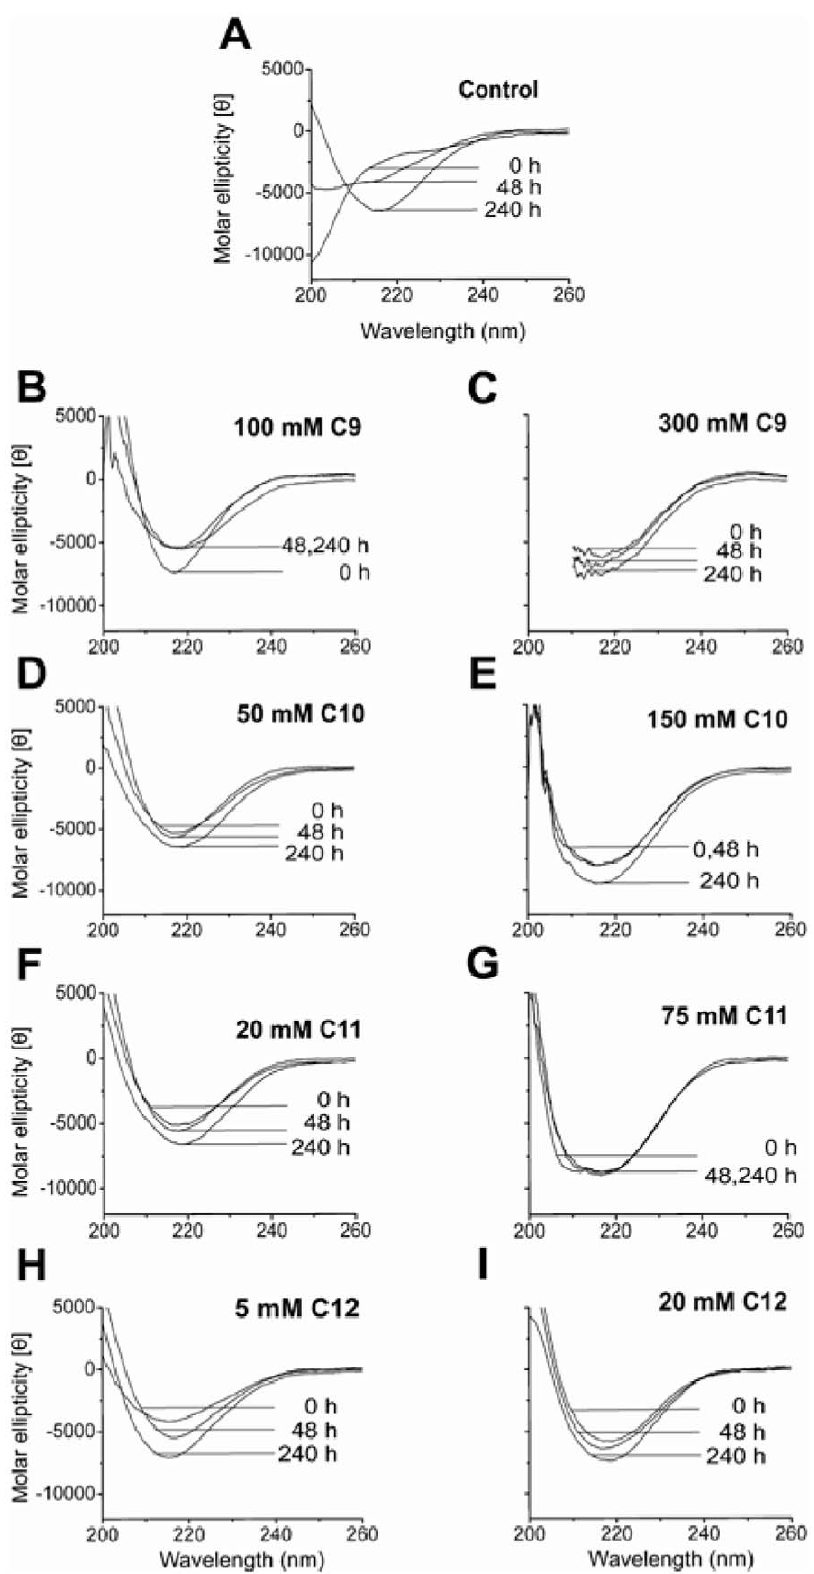
Figure 3. Secondary structure change indicated by far-UV CD during incubation of A b 42 with varying concentrations of NEFAs, C9, C10, C11 and C12 near (left panel) or above (right panel) their respective CMCs.